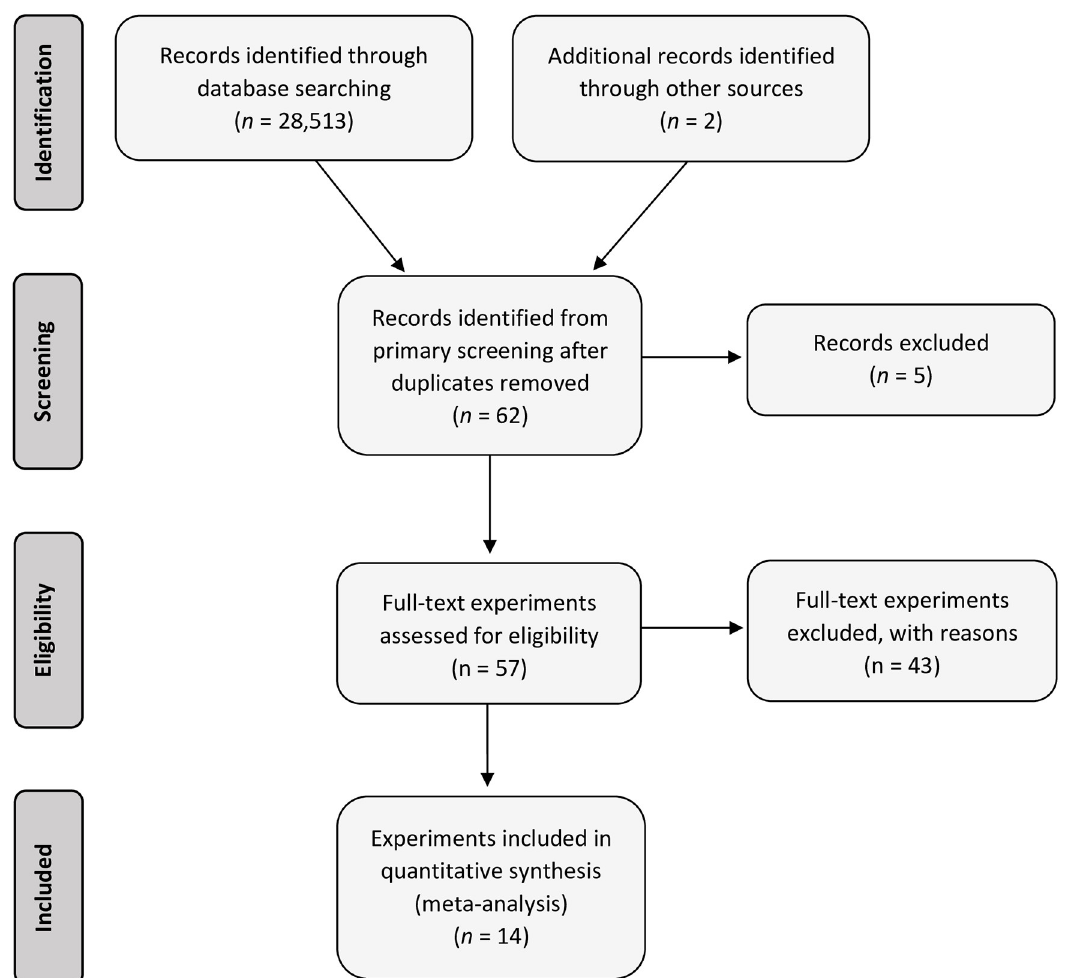
Fig 1. PRISMA flow diagram (adapted from [6]) of the systematic review from initial search and screening to final selection of publications to be included in the meta-analysis on seaweed in cattle. The n refers to the number of records for identification and screening that includes experimental articles, abstracts, books, review papers, theses, patents and other records, whereas for the eligibility and included stages n refers to the number of experimental articles, that is